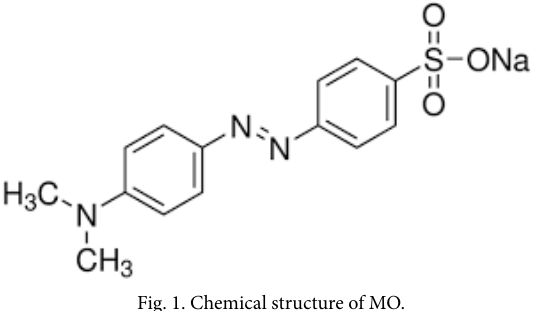
Fig. 1. Chemical structure of